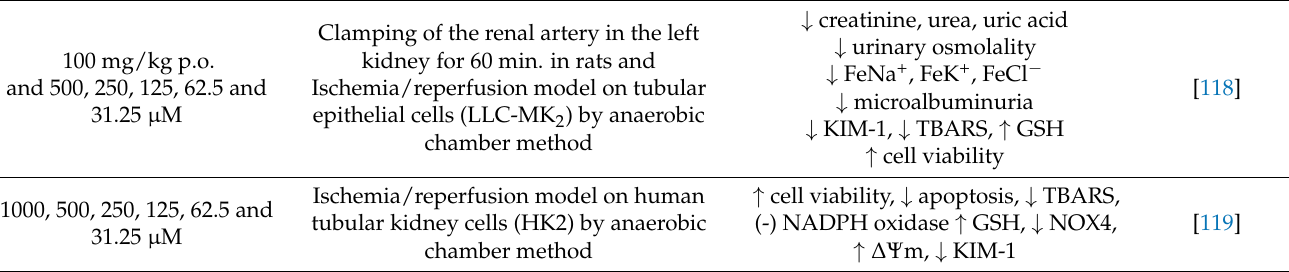
Table 10. Nephroprotective effects of α